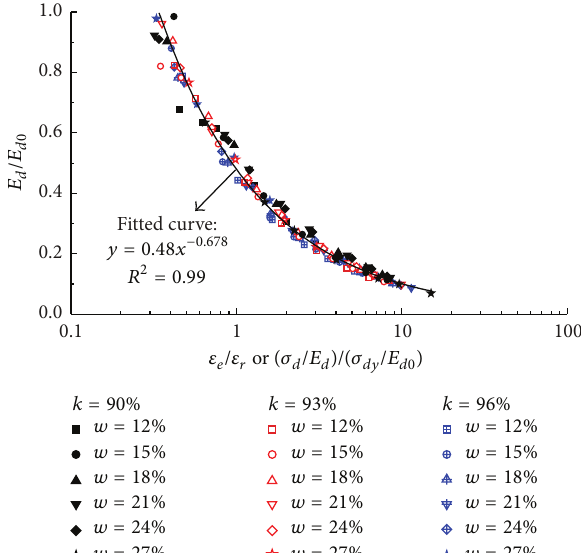
Figure 3: Correlation of 𝐸 𝑑 /𝐸 𝑑0 with (𝜎 𝑑 /𝐸 𝑑 )/(𝜎 𝑑𝑦 /𝐸 𝑑0 ) .